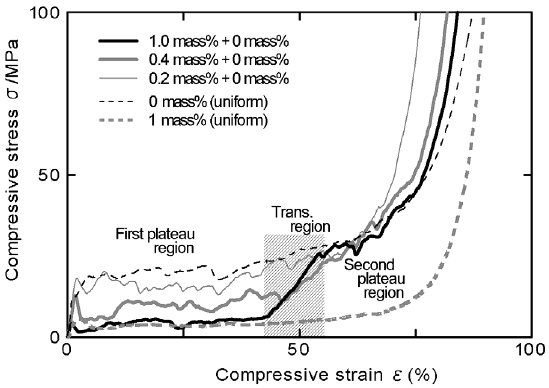
Figure 3. Relationship between compressive stress and strain of FG aluminum foam.